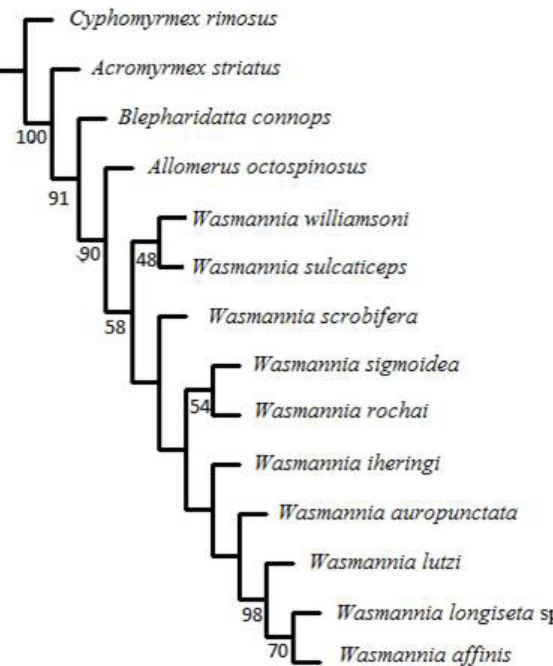
Fig 9 . The singlemost parsimonious cladogram obtained under implicit enumeration (Length = 93.648, CI = 0.718, RI = 0.619). Numbers below nodes represent support values as frequency differences, only those values close to GC=50 are